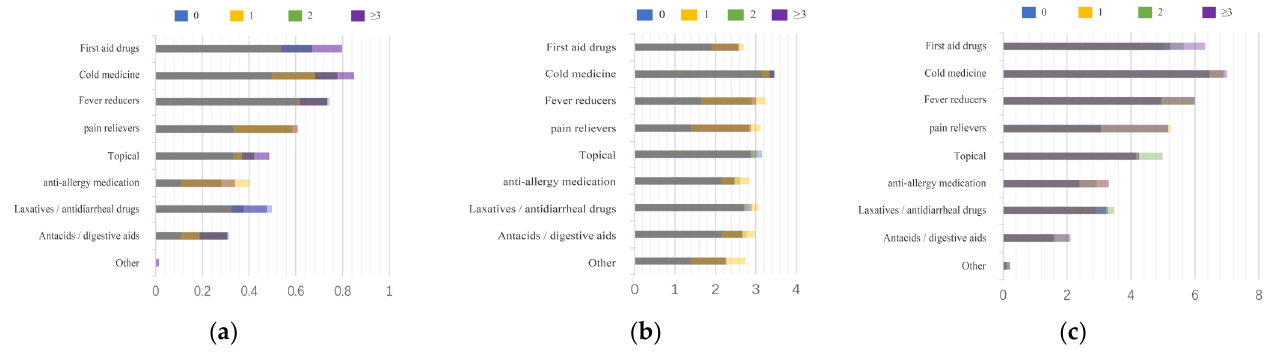
Figure 8. Summary of drug stockpiling, frequency of drug use, and ranking of drug importance for different number of people living together. ( a ) Stockpile, ( b ) Frequency, ( c ) Rank.